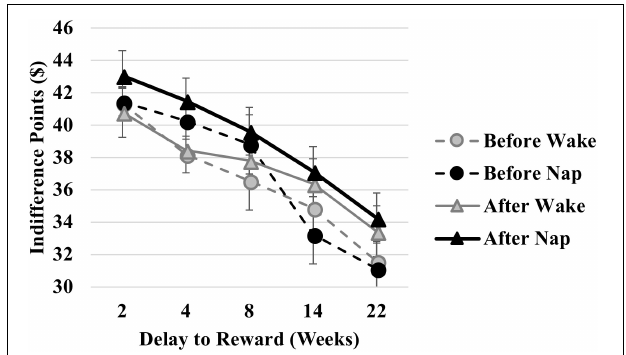
FIGURE 2 | Comparison of indifference points across time delays (2, 4, 8, 14, and 22 weeks) before (circles) and after (triangles) an afternoon nap (black symbols/lines) and equivalent interval awake (gray